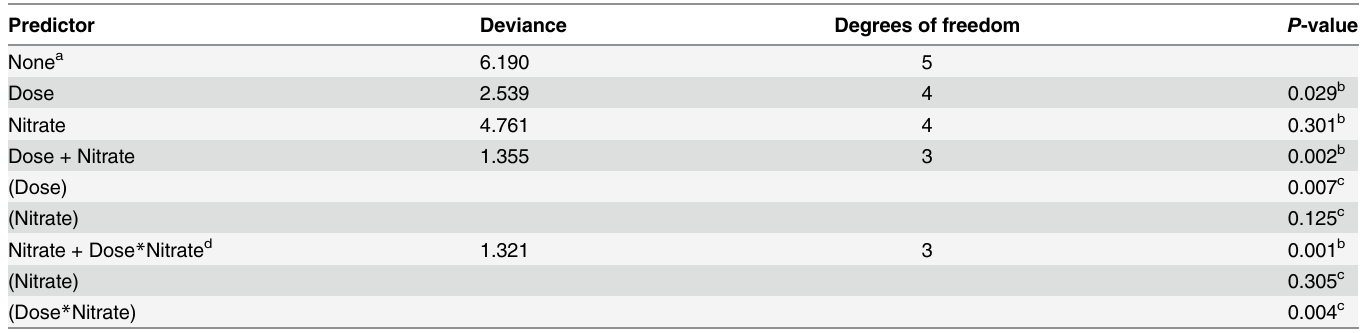
Table 3. Relationship between childhood thyroid cancer incidence, radiation thyroid dose and nitrate in groundwater in Belarus. Predictor Deviance Degrees of freedom P -value None a